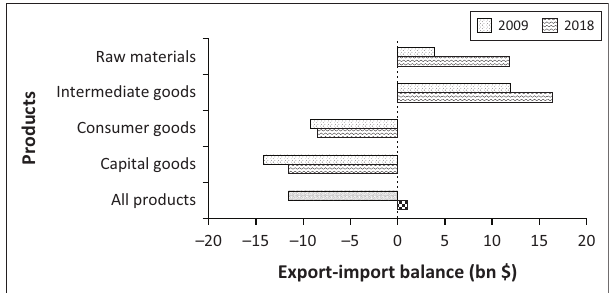
FIGURE 4 : Export-import balance of South Africa for main product groups (in constant $